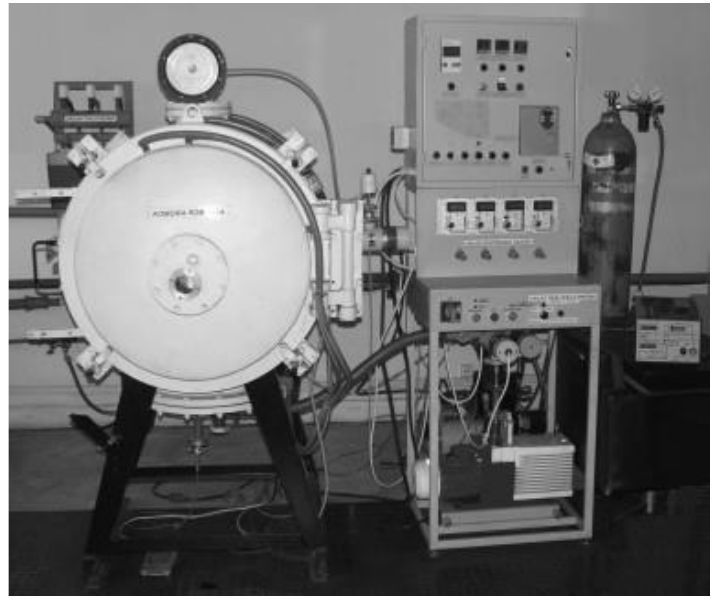
Figure 3. View of the fluorescent nitriding device used in the research.